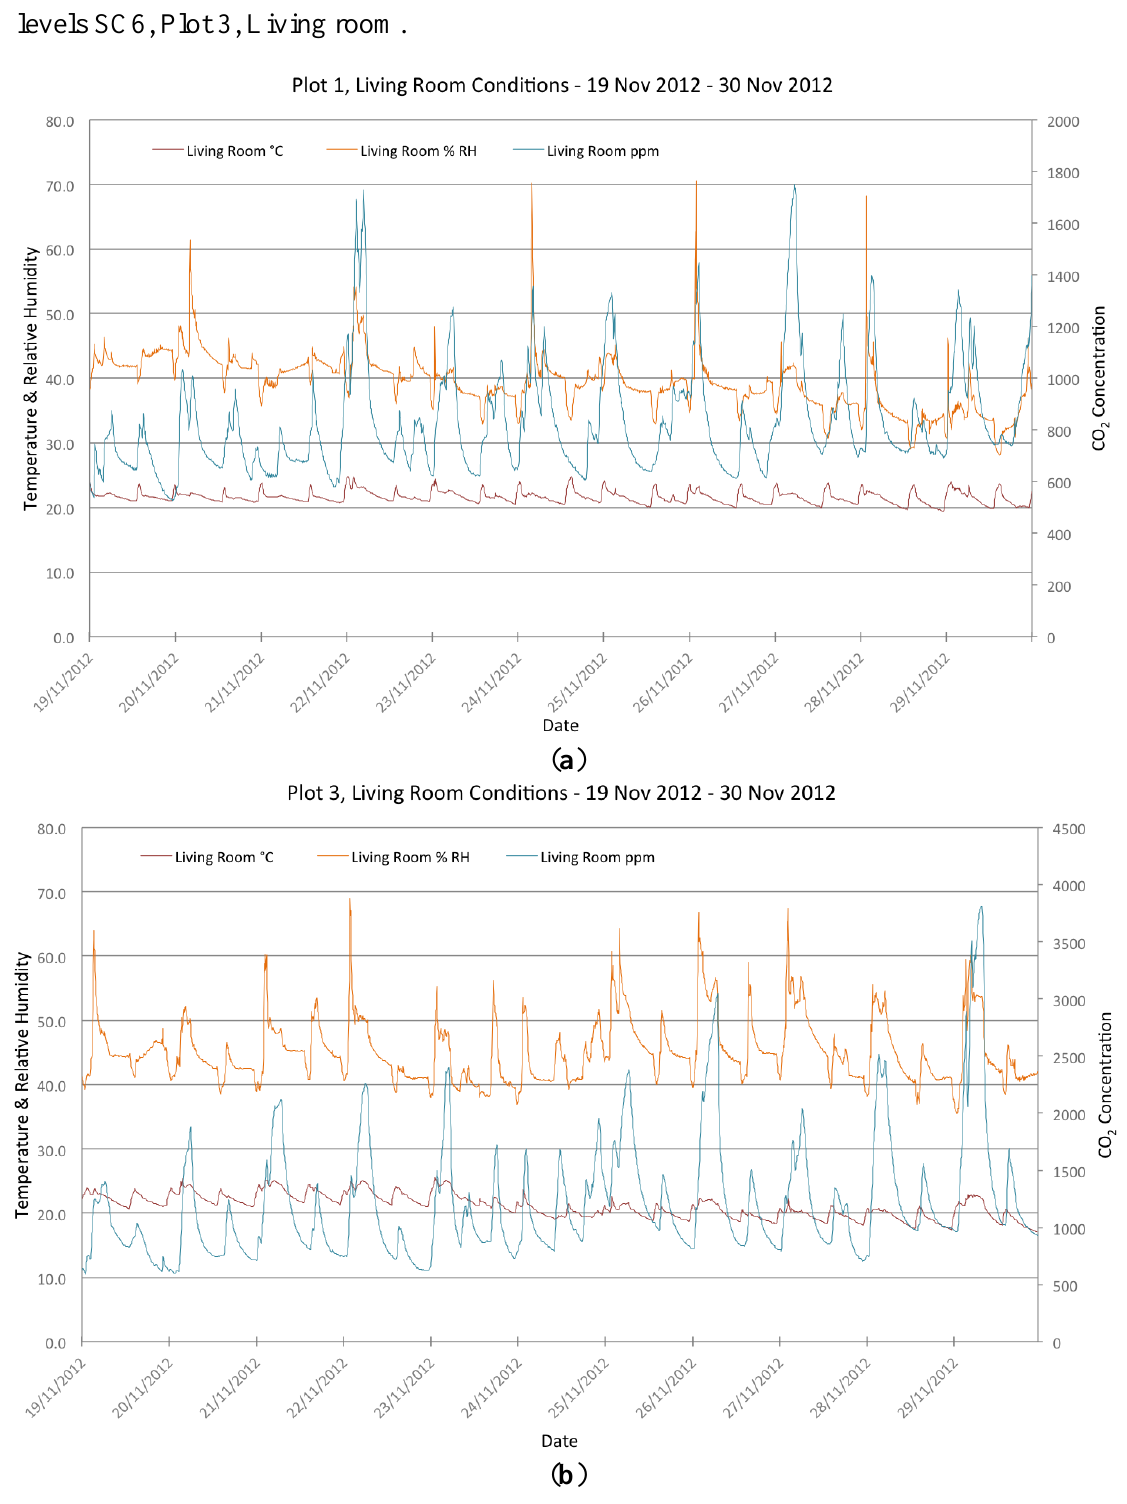
Figure 9. ( a ) CO 2 temp and RH levels SC6, Plot 1, Living room; ( b ) CO 2 temp and RH levels SC6, Plot 3, Living room.